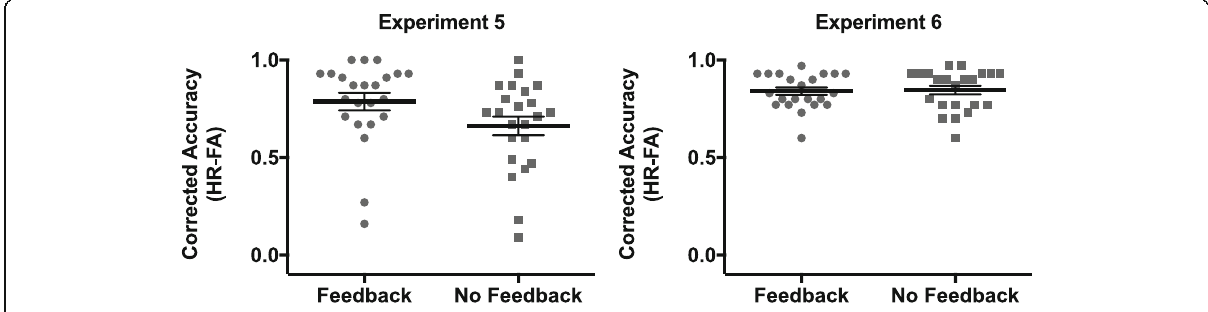
Fig. 3 Results for Experiments 5 and 6. Error bars represent standard error of the